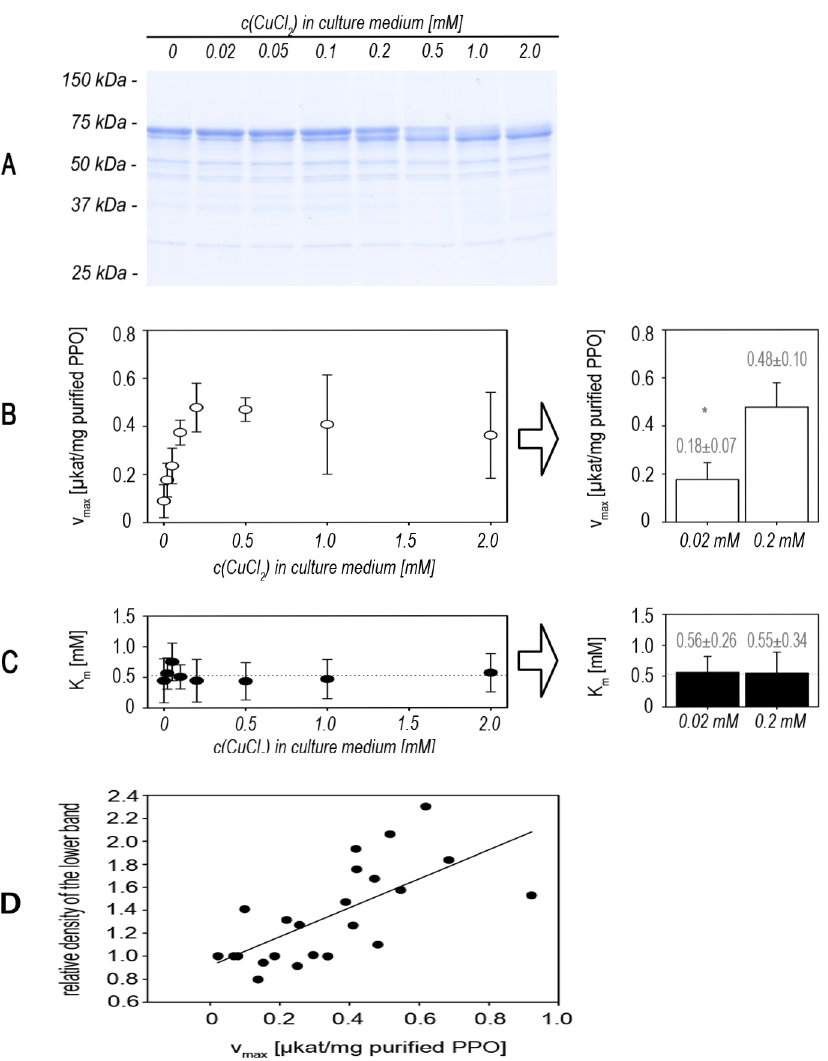
Figure 7. Influence of copper supplementation on enzymatic parameters. Production cultures were grown with different concentrations of supplemented CuCl 2 in AIM. A SDS-PAGE of purified proteins. ToPPO-2 was purified via affinity-chromatography using Strep-Tactin. Equal protein amounts were loaded on an acrylamide gel and analyzed by SDS-PAGE and Coomassie-staining. B Maximal activities (v max ) and C Michaelis constants (K m ). Enzyme kinetics were performed on 4-methylcatechol as substrate and enzymatic parameters were determined by non- linear regression to the Michaelis-Menten equation. * P , 0.01 in Student’s t-test (n=4); K m -values were not significantly different (P=0.955). D Correlation between the lower band appearing on SDS-PAGE and v max . Data given are from three independent experiments. Analysis of the relative density of protein bands was performed using ImageJ [32] calculating the lower band in relation to the respective upper one. Poor separation of double bands at higher copper concentrations (1 – 2 mM) precluded their accurate quantification so that only data from the lower concentrations (0 – 0.5 mM) are included. Statistics for correlation was performed using SigmaPlot11 and Pearson Product Moment Correlation, giving a significant positive correlation (corr. coefficient=0.676, p , 0.001, n=23) between the tested parameters.